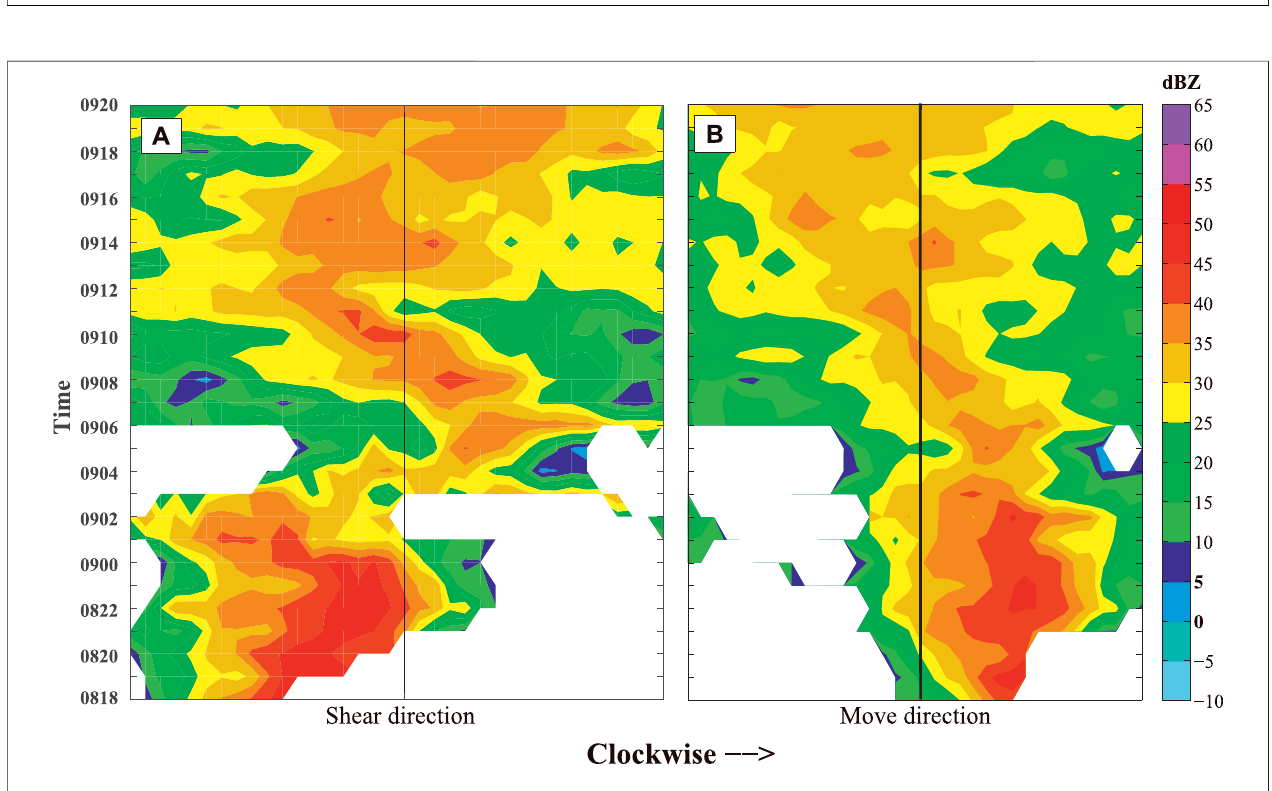
FIGURE 4 | Corresponding relationship between location of radar echo near eyewall and wind shear direction (A) or movement direction (B) .